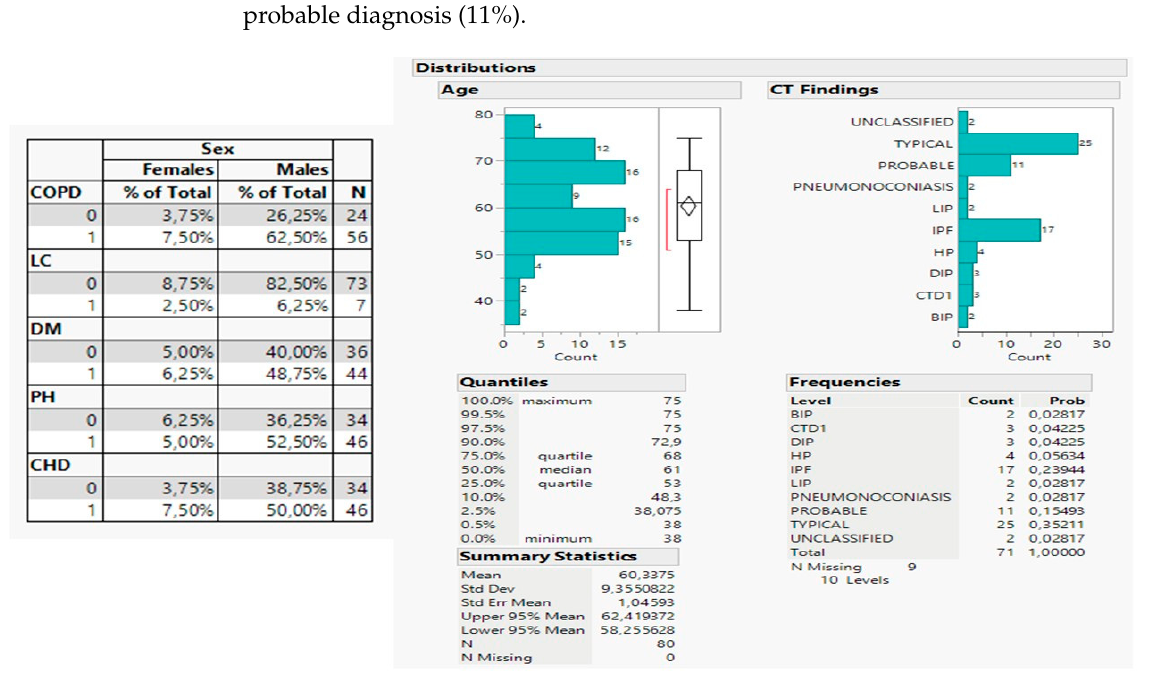
Figure 2. Table of medical history plus age and CT readings distribution. Left: disease distribution, Right: Distribution of age with computed tomography findings. IPF: idiopathic pulmonary fibrosis, LIP: lymphoid interstitial pneumonia, HP: hypersensitivity pneumonia, BIP: bronchiolitis obliterans pneumonia, CTD1: connective tissue disease, DIP: desquamative interstitial pneumonia, COPD: chronic obstructive pulmonary disease, LC: lung cancer, PH: pumonary hypertension, CHD: coronary heart disease, DM: diabetes melitus.